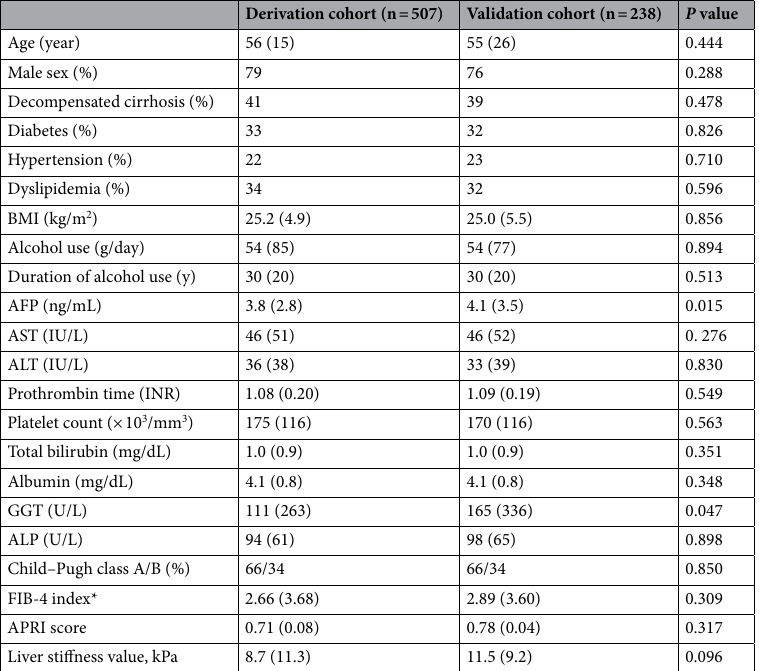
Table 1. Baseline characteristics of patients with alcoholic cirrhosis. Continuous variables were expressed as their median values (interquartile range), and p-value was calculated using Wilcoxon rank-sum test. Categorical variables were expressed as absolute numbers (percentages), and p-value was calculated using chi- square test. FIB-4 index 33 = age (yr)xAST (U/L)/Platelet count (10 9 /L)x(ALT(U/L)) 0.5 . APRI score = AST(U/L)/ platelet counts (10 9 /L)*0.4. BMI, body mass index; HbsAg, hepatitis B surface antigen; Anti-HCV, antibody against hepatitis C virus; AFP, alpha-fetoprotein; AST, aspartate aminotransferase; ALT, alanine aminotransferase; INR, international normalized ratio; GGT, gamma-glutamyltransferase; ALP, alkaline